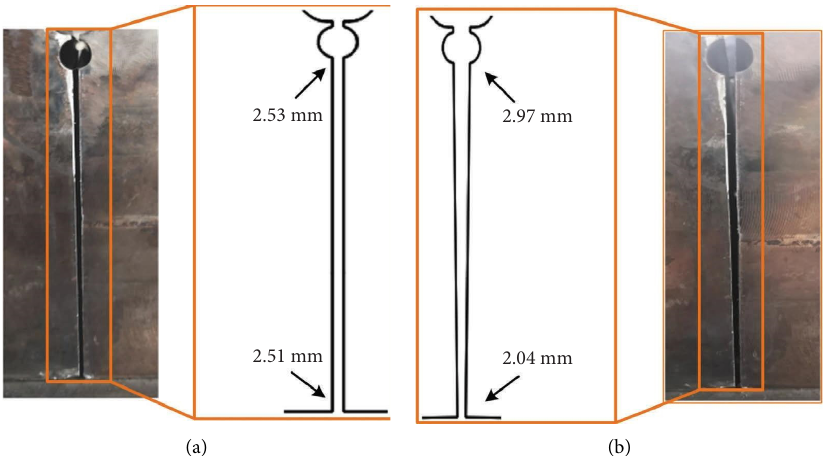
Figure 10: Comparison of the side clearance of the azimuth track. (a) Side clearance before the opposite force is applied. (b) Side clearance after the opposite force is applied.